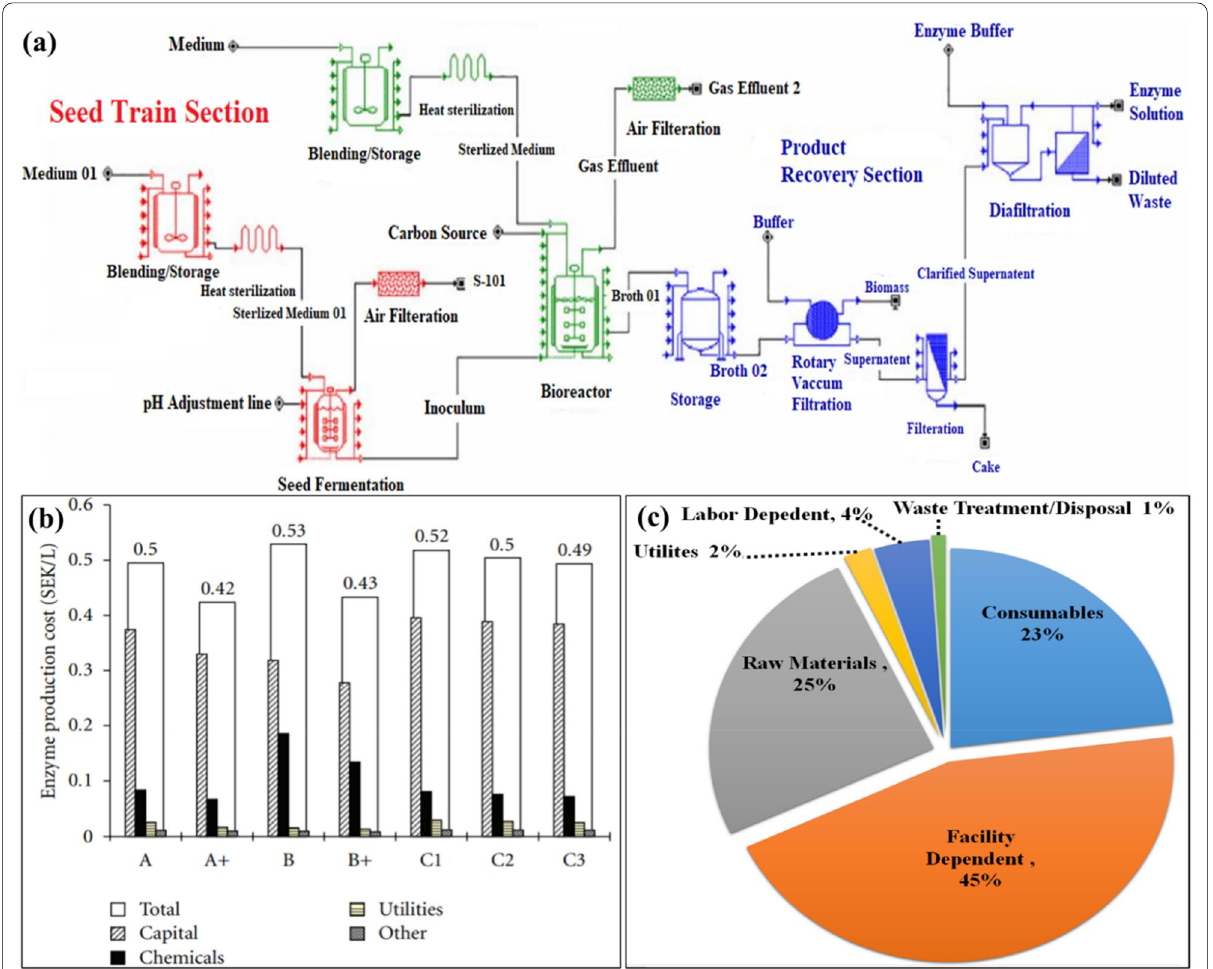
Fig. 4 Techno-economic aspect of cellulase production: a generic flowsheet of a cellulase production process with filamentous fungi [adapted with permission (Ferreira et al. 2021)]. b Cost contributors of enzyme production in (Swedish kronor) SEK/L ethanol. A, A B, B : pretreated liquid fraction and molasses and C1, C2, C3: pretreated liquid fraction and pressed pretreated slurry with a total WIS content of + 1%, 2% and 3%; : 1.5-fold specific activity (adapted from Barta et al. 2010). c Composition of the enzyme cost for recombinant β-glucosidase + production using the baseline scenario (adapted and modified from Ferreira et al.